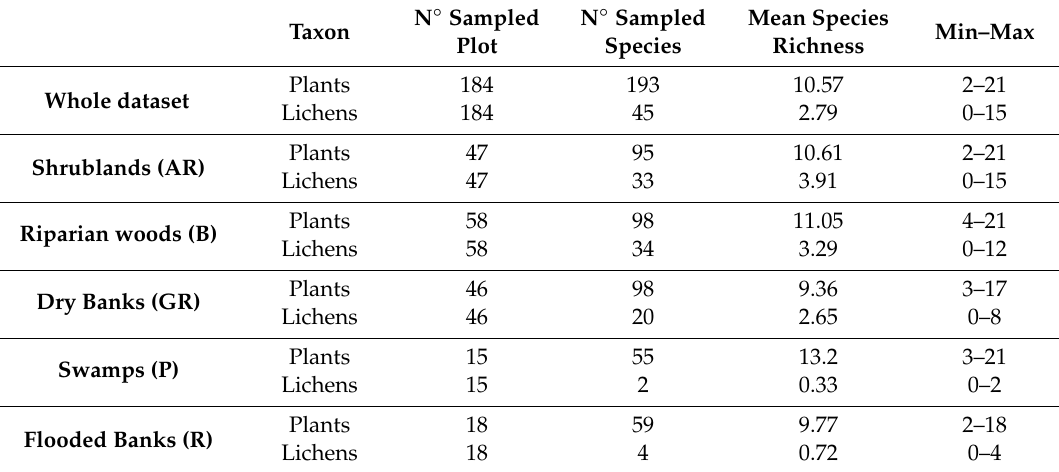
Table 1. Summary statistics of the analyzed